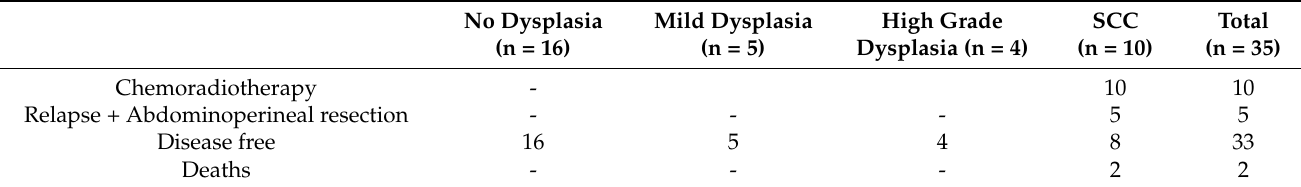
Table 2. Outcomes of patients of the